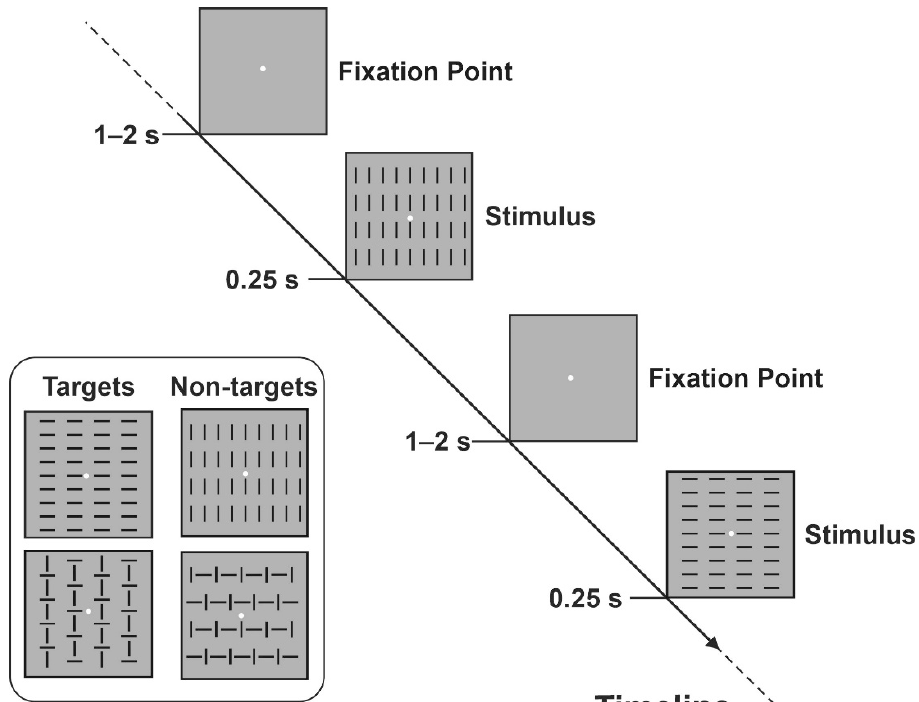
Figure 4. Schematic illustration of the Go/No-go task.